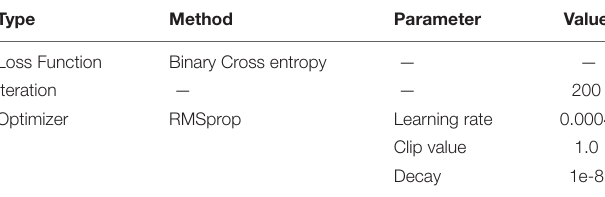
TABLE 3 | Optimizer and cost of